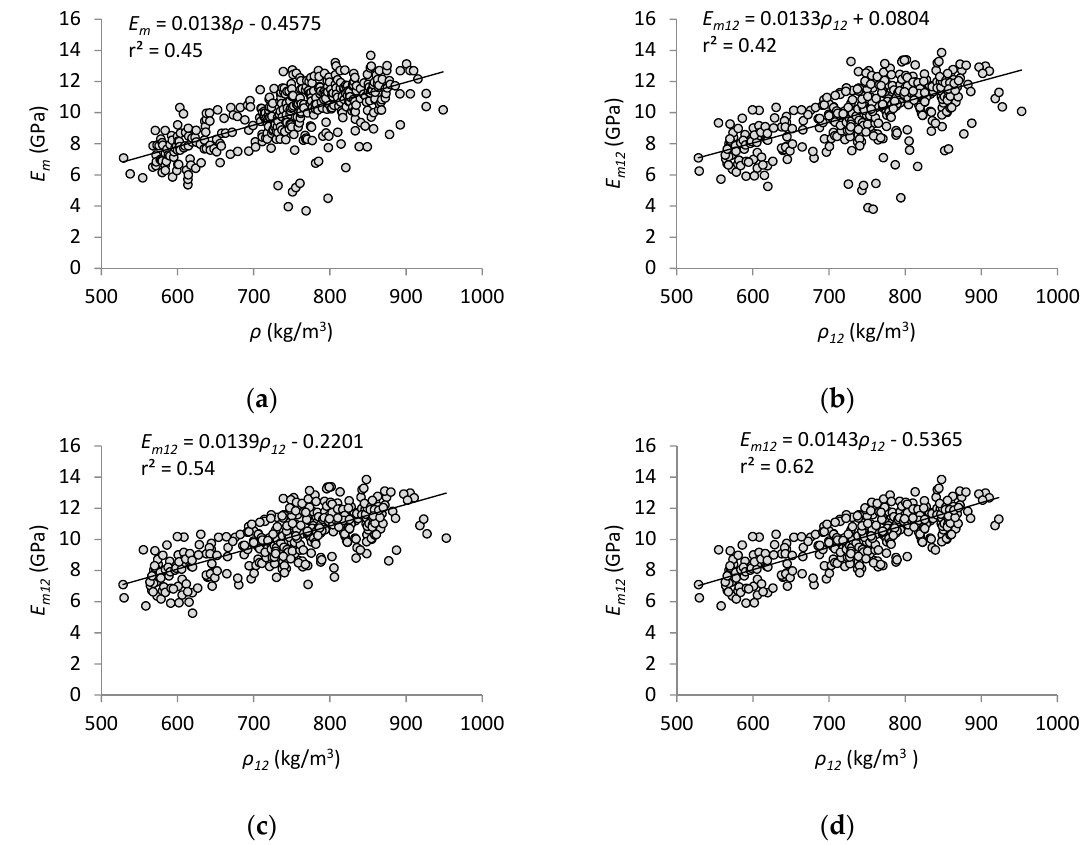
Figure 3. Correlation between density ( ρ ) and modulus of elasticity ( E m ): ( a ) With the moisture content at the time of the tests (Phase 1); ( b ) After the correction for a 12% of moisture content (Phase 2); ( c ) After excluding the outliers (Phase 3); ( d ) After excluding 5% of the values farthest from the linear regression expression. Table 4. Correlation between density ( ρ ) and modulus of elasticity in bending ( E m ).